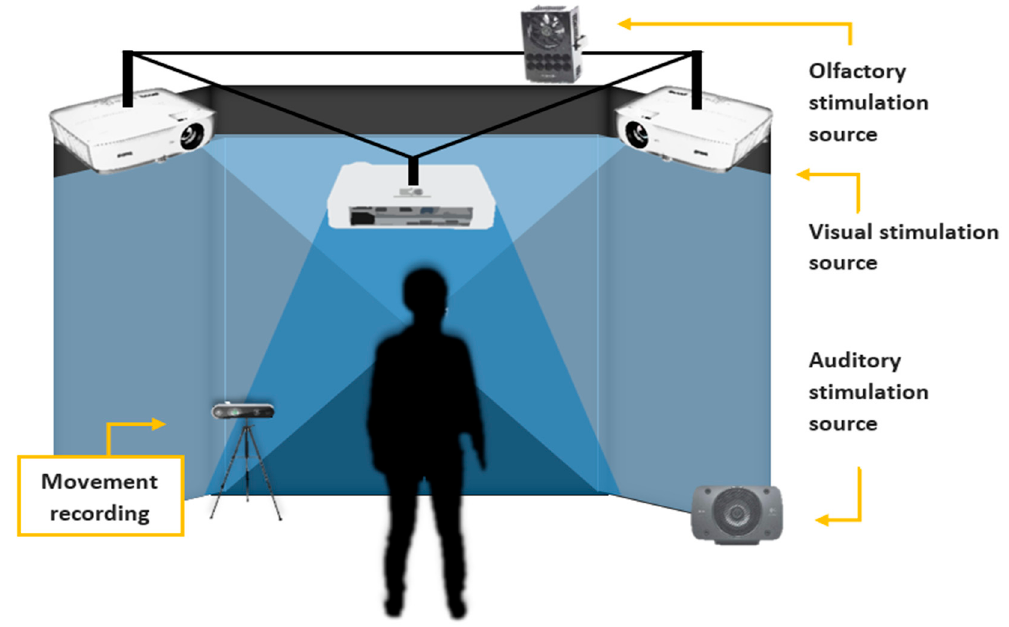
Figure 2. Experimental setting.